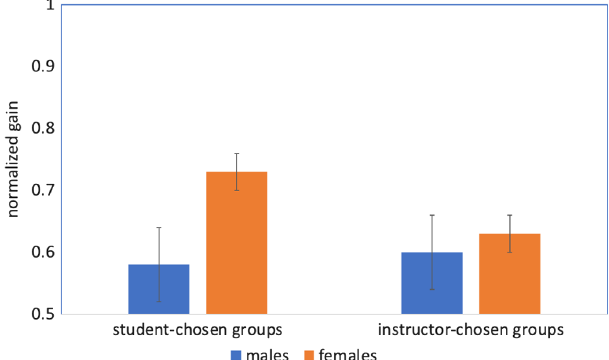
FIG. 3. Comparing average male and female students ’ normal- ized gain for two-part collaborative exams (difference between group exam score and individual exam score, normalized to individual exam score) for students in student-chosen groups versus instructor-formed groups. Error bars represent the standard error of the